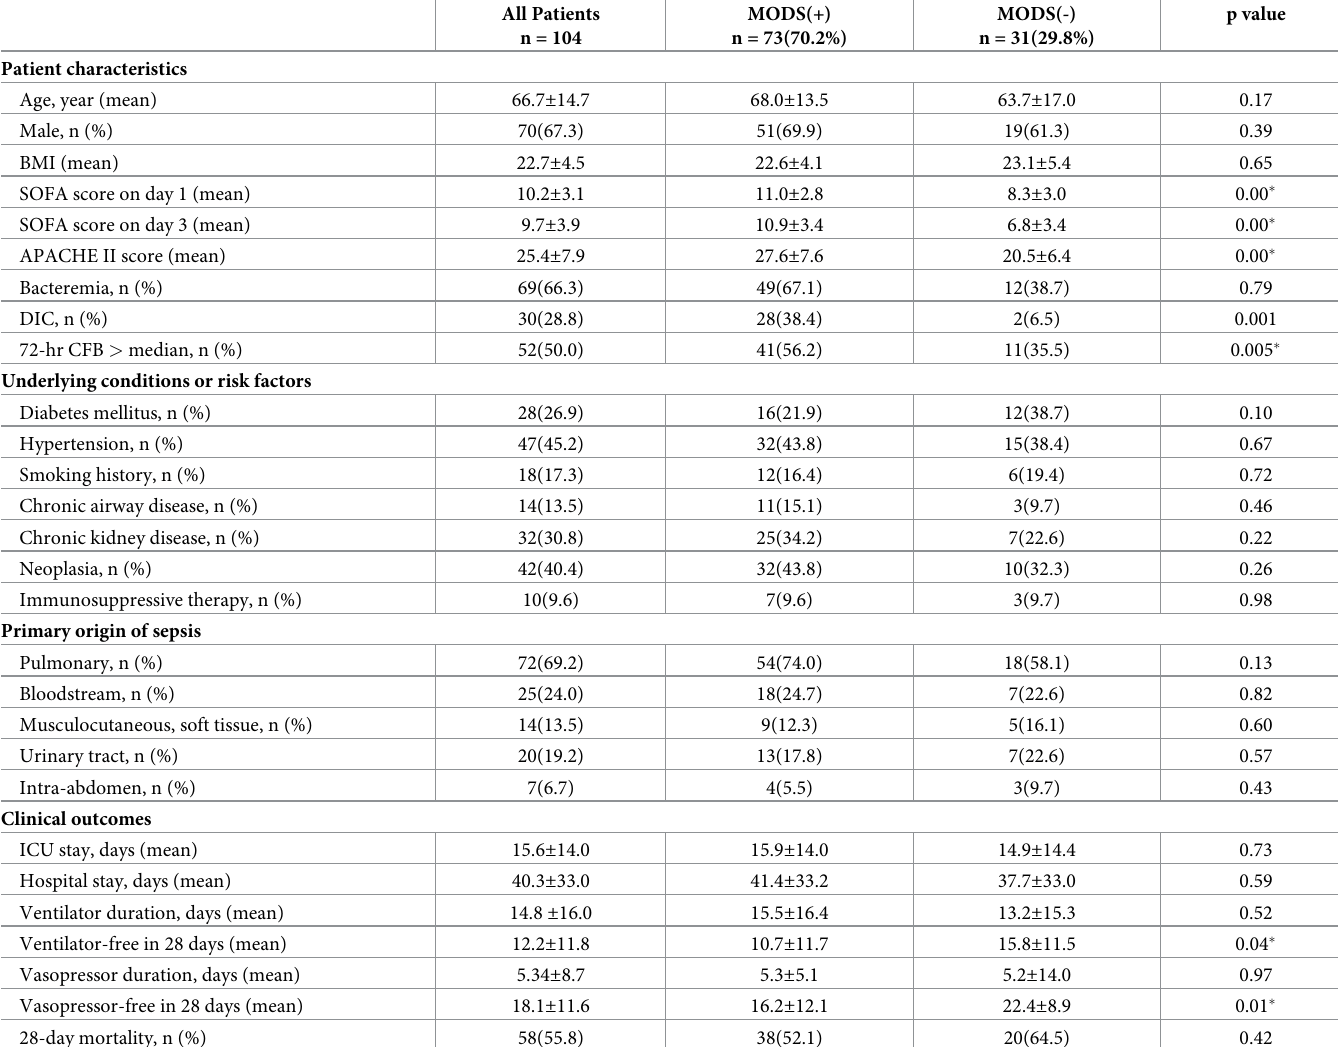
Table 1. Characteristics and outcomes of patients with MODS and without MODS on day 3 following the onset of septic shock.